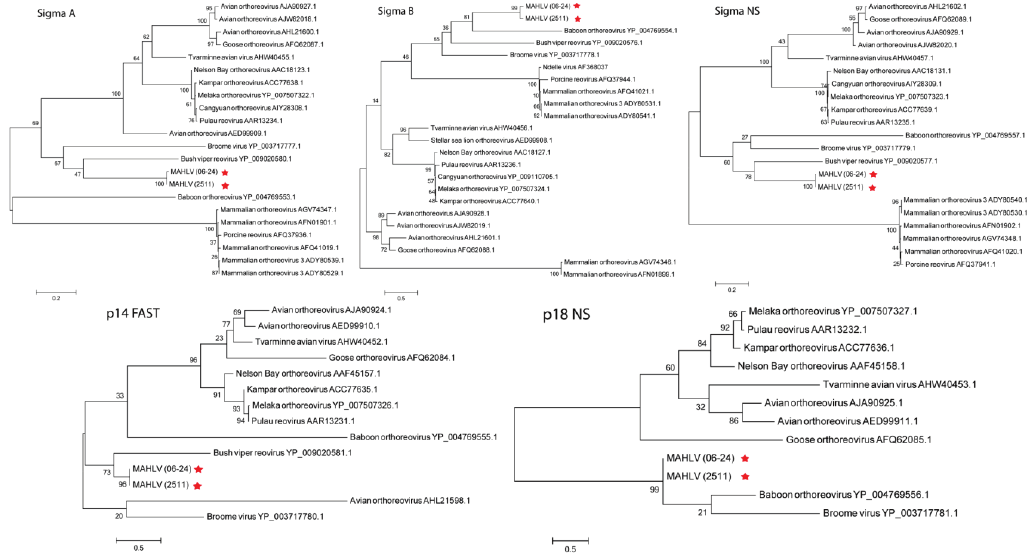
Figure 10. Molecular phylogenetic analysis by Maximum Likelihood method showing the placement of MAHLV within the Orthoreovirus genus using amino acid sequences of the five ORFs in the four small segments, S1, 2, 3 and 4 coding for proteins Sigma A, B, NS, and p14 FAST and p18 NS.